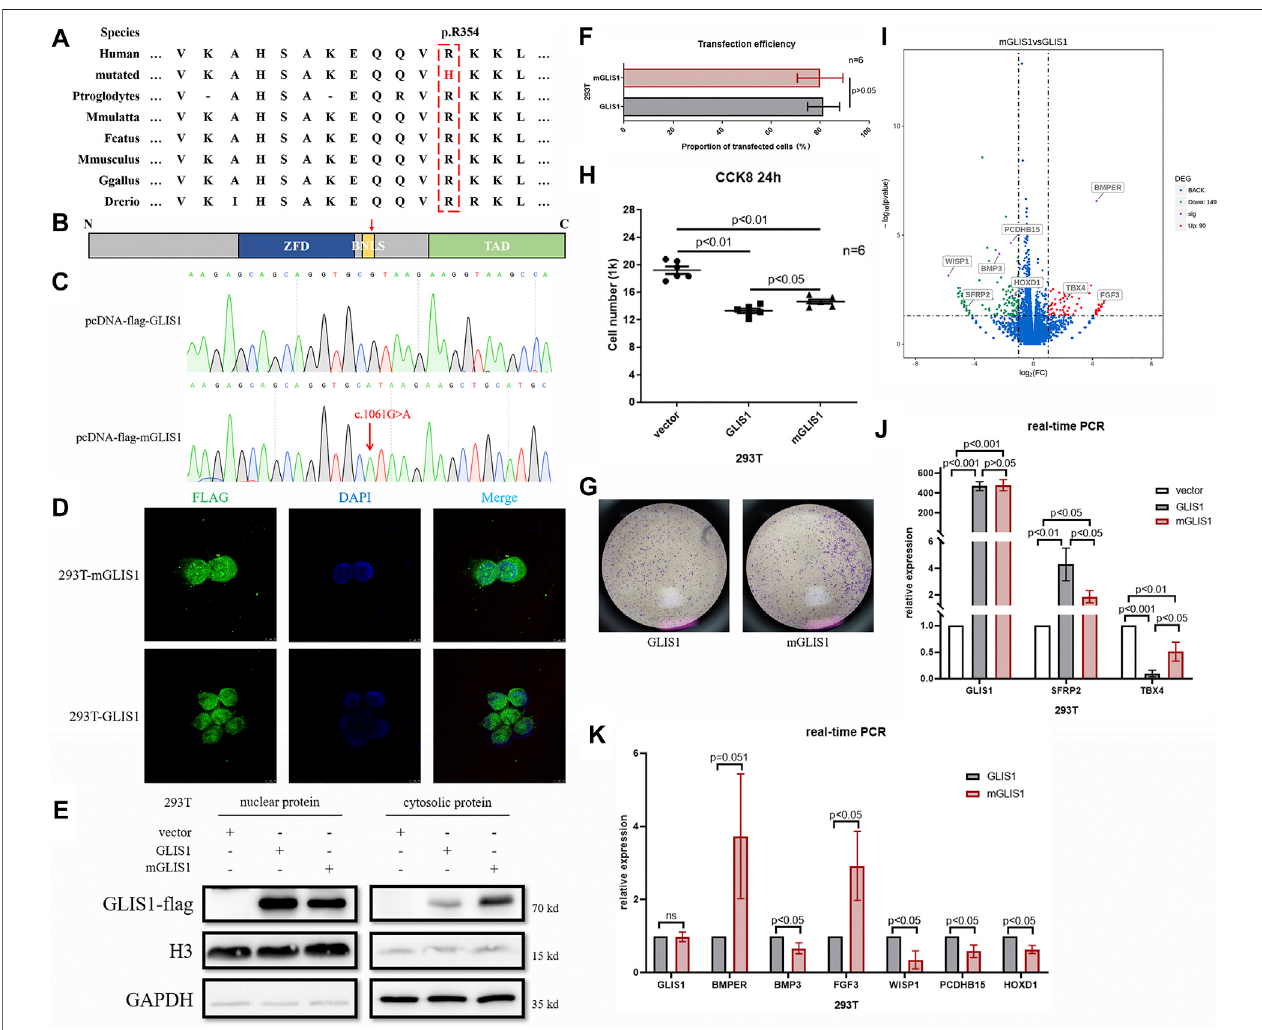
FIGURE 2 | Functional analysis of variant p.R354H in vitro . (A) Species conservation analysis of the mutant amino acid of GLIS1. (B) Schematic diagram of GLIS1 structure. Red arrow indicates variant p.R354H. (C) Sequencing results of GLIS1-1061G > A mutagenesis plasmids. (D) Immuno fl uorescence results demonstrating that mutant GLIS1 had increased cytoplasmic retention and reduced the proportion of nuclear protein. (E) Western blot showed that compared with wild-type, nuclear protein of the mutant GLIS1 was reduced, and cytosolic protein was increased. (F) The transfection ef fi ciency of GLIS1/mGLIS1 plasmids in 293T cells. (G, H) CCK8 and transwell results showing that mutant GLIS1 promoted cell viability and migration. “ p < 0.05 ” presents data with statistical signi fi cance, “ p > 0.05 ” presents data without statistical signi fi cance, and “ n ” represents the number of cell samples. (I) A volcano plot based on RNA sequencing data. (J, K) Validation of RNA sequencing data by the real-time PCR. “ p < 0.05 ” presents data with statistical signi fi cance, and “ p > 0.05 ” presents data without statistical signi fi cance.